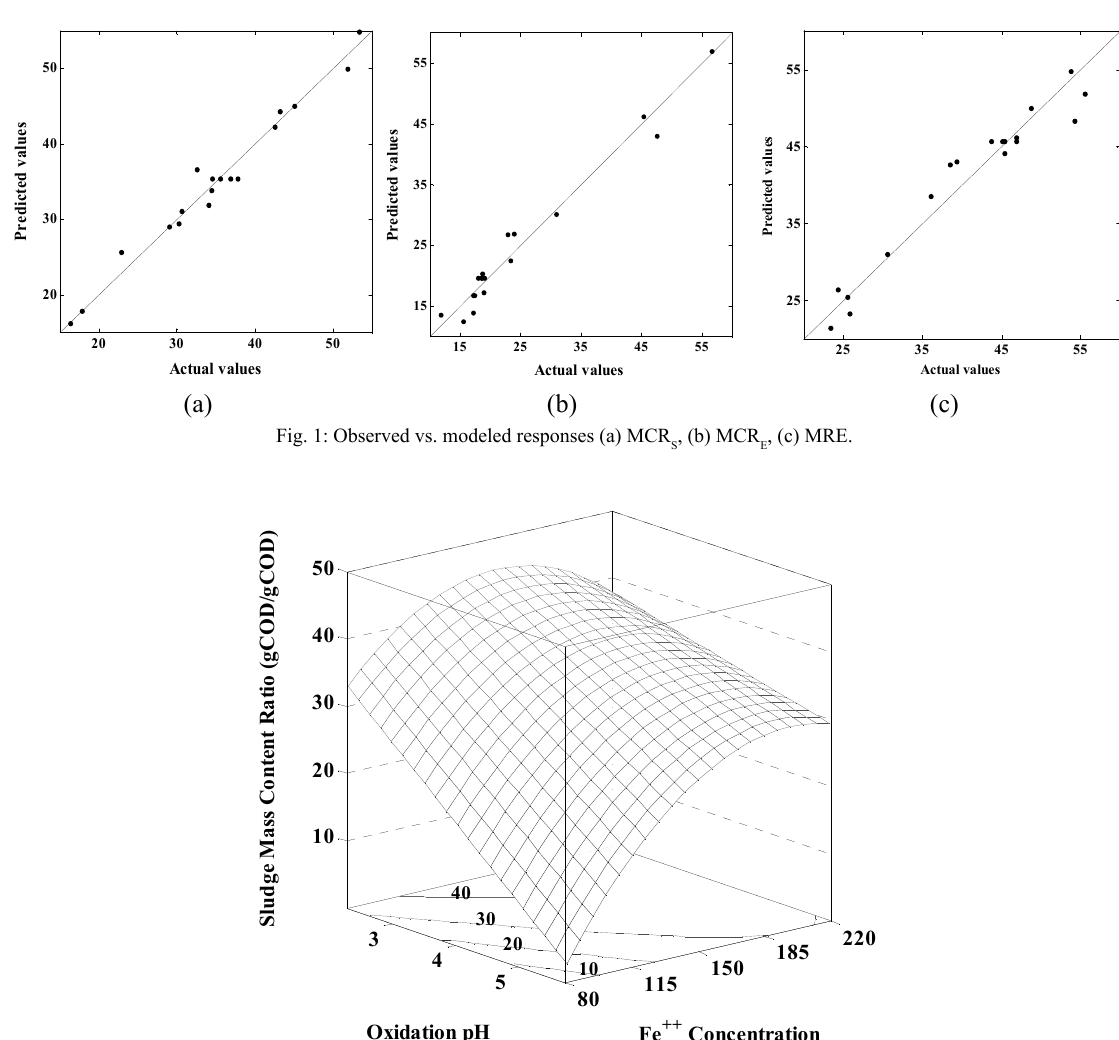
Fig. 2: MCR ( Y ). The response surface in terms of initial pH and Fe 2+ dosage ([H S 1 ( Y ). The response surface in terms of initial pH and Fe 2+ dosage ([H S 1